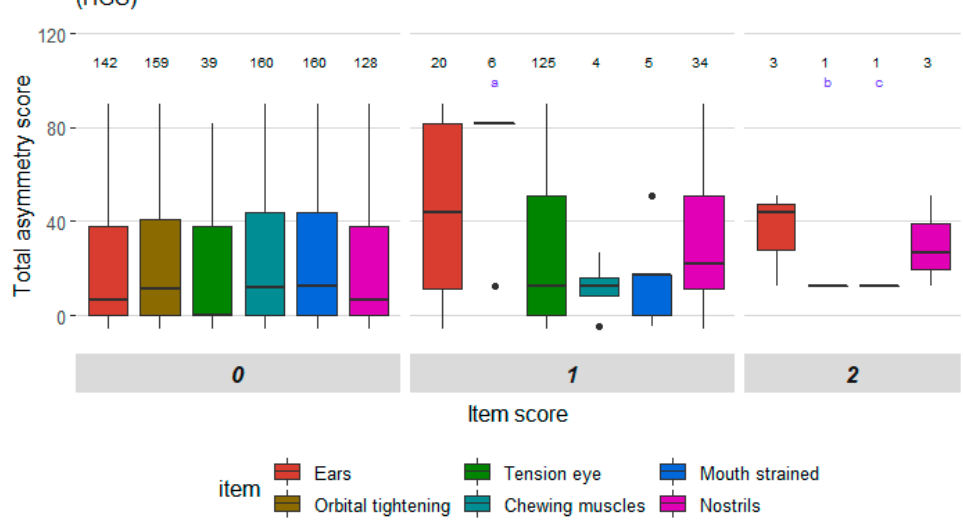
Figure 1. Distribution of item scores for Horse Grimace Scale (HGS). Total asymmetry score is presented on the y-axis. Scale items are presented on the x-axis and divided into the item scores given (ranging from 0 to 2). Item scores for all observers are included and number of scores ( n ) is stated above each box. Outliers are included and shown as black dots. The black line in the boxes shows the median and the upper and lower ends of the boxes show the upper and lower quartile. The upper and lower whiskers show the highest and lowest 25% of the data. Some of the boxes contain few observations and low spread, and appear as horizontal lines where the color is not visible. Instead, they are marked with letters in the diagram: a—orbital tightening, b—tension above the eye area, c —prominent strained chewing muscles.